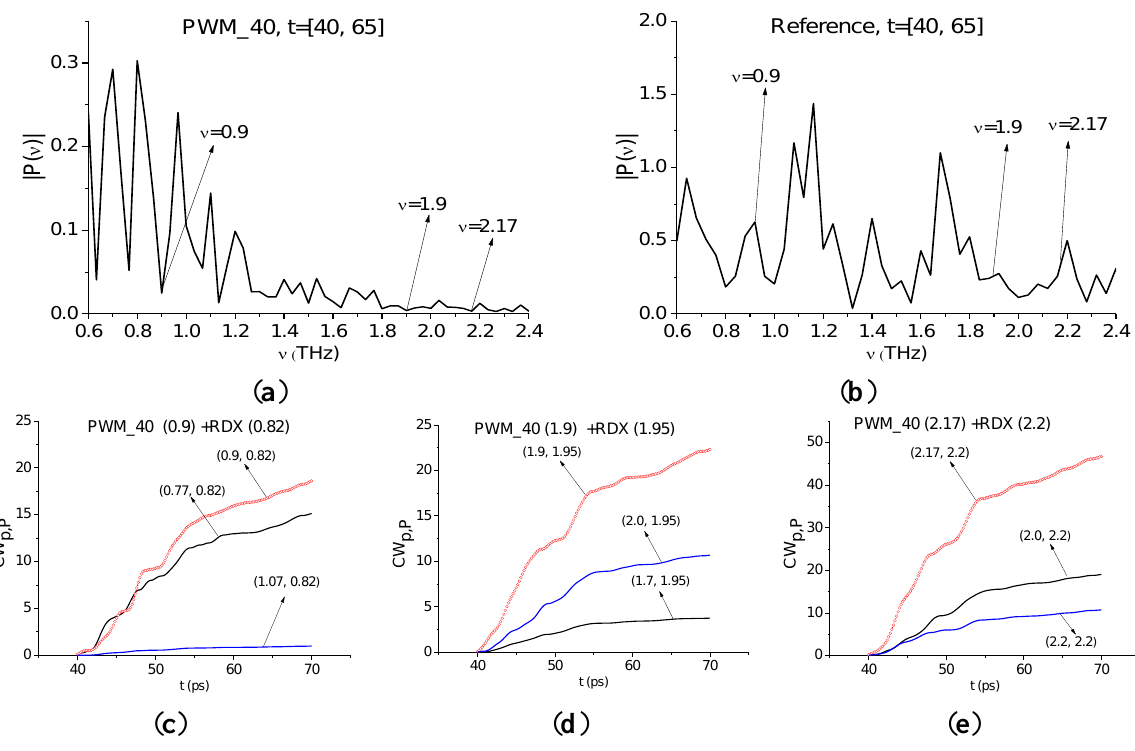
Figure 15. Fourier spectra of the first sub-pulse for the PWM_40 signal ( a ) and Reference signal ( b ) in the frequency range ν = [0.6, 2.4] THz, integral characteristics CW p , P ( t n ) calculated with the frequencies ν = 0.9 THz ( c ); 1.9 THz ( d ); 2.17 THz ( e